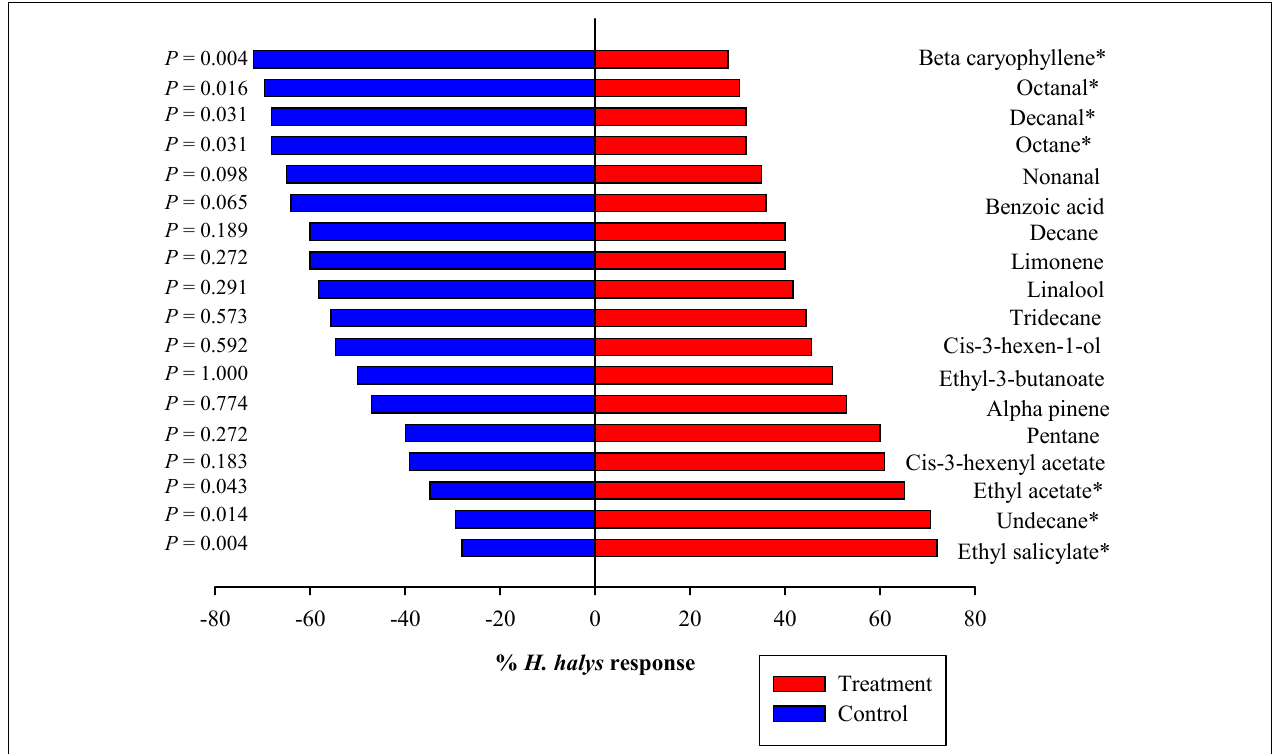
FIGURE 2 | Responses of Halyomorpha halys nymphs to synthetic compounds in a Y-tube olfactometer. Percentage of H. halys ( n = 30) responding to the single compounds. Asterisks indicate significant difference between the treatments at p = 0.05 using likelihood ratio test.